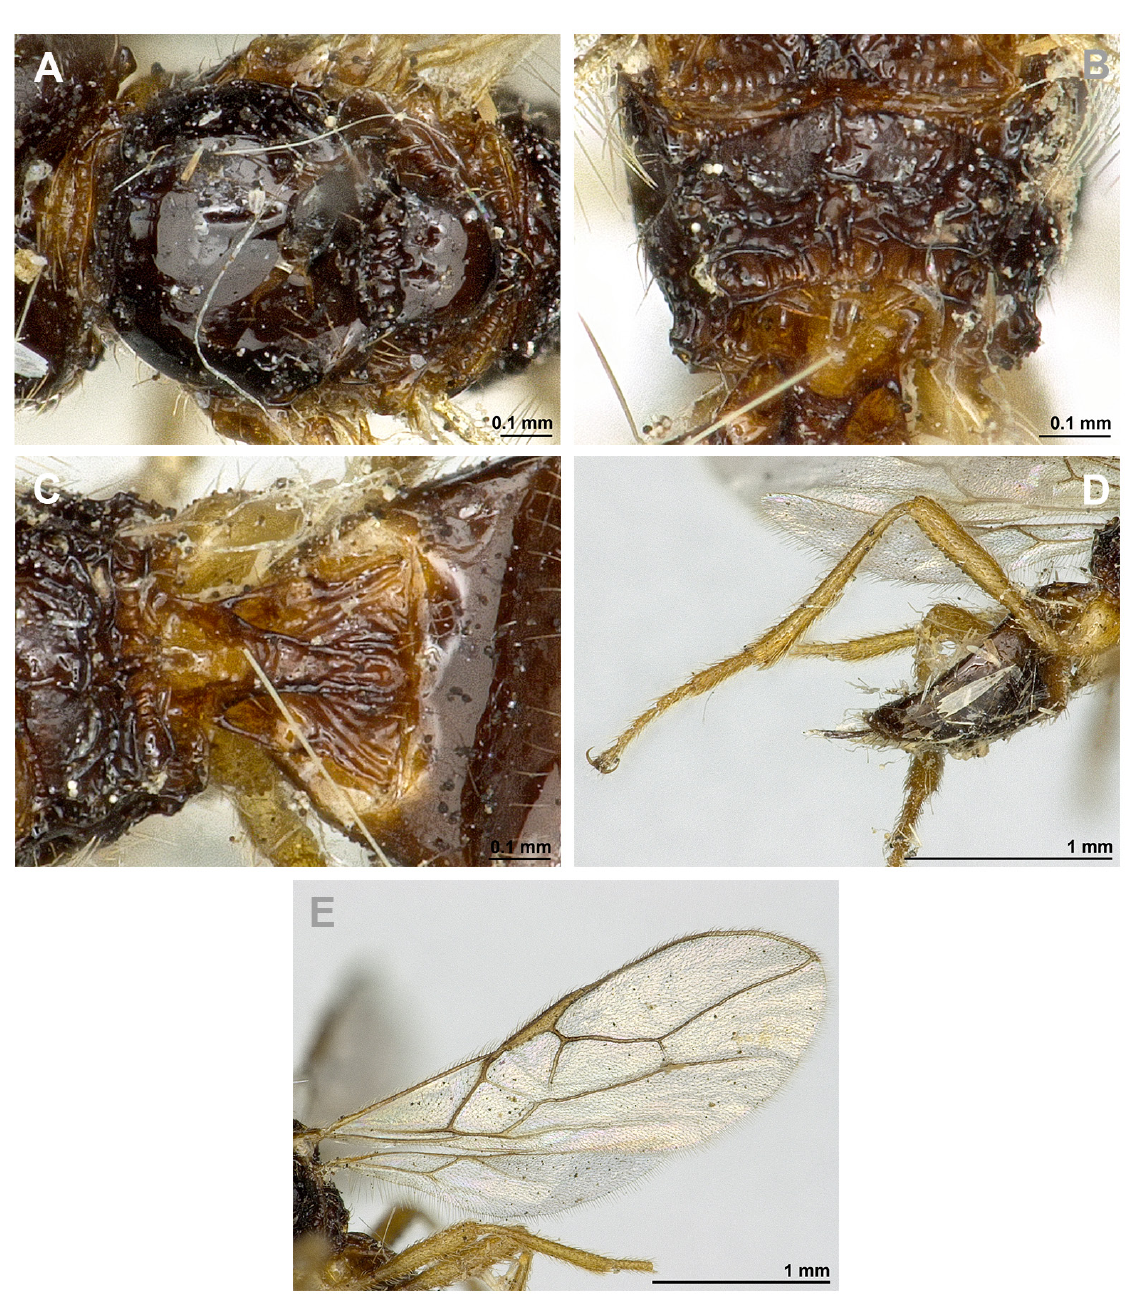
Fig. 51. Asobara robusta van Achterberg, sp. nov., ♀, holotype (RMNH 7597). A . Head and mesoscutum, dorsal view. B . Propodeum, dorsal view. C . First metasomal tergite, dorsal view. D . Hind leg, metasoma and ovipositor, lateral view. E . Fore and hind